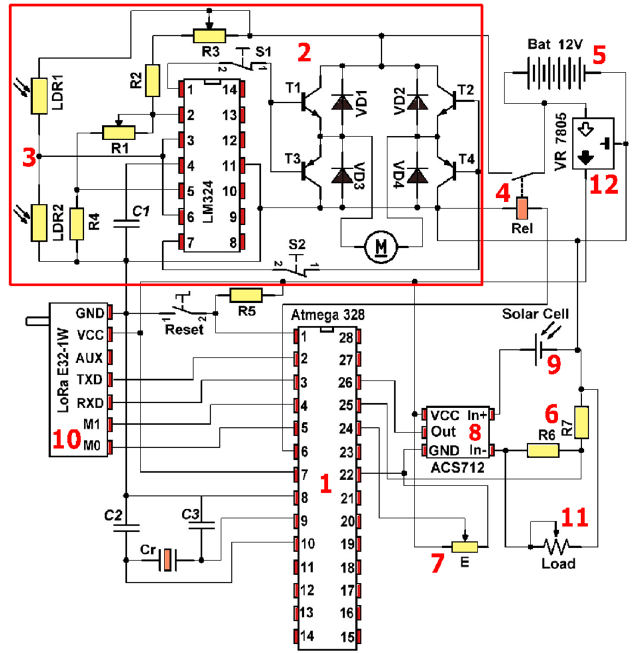
Figure 6. Functional diagram of the electronic control unit of a single-axis solar tracking system based on photoresistors.